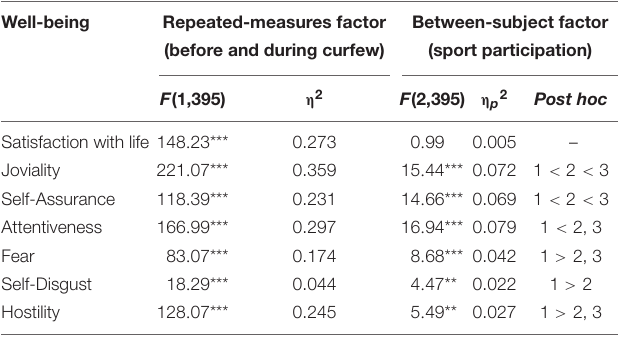
TABLE 6 | Results of mixed ANOVAs: differences in well-being before and during the curfew between non-athletes, recreational athletes, and elite athletes ( N = 398).